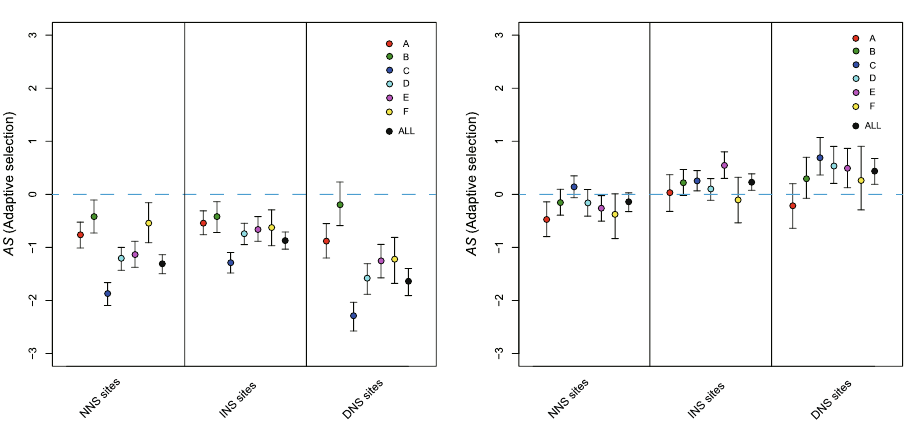
Figure 3. Adaptive evolution of non-synonymous variants in HBV. ( A – B ) Plots of AS statistics of NNS, INS and DNS variants. The calculation was performed using ( A ) low frequency and ( B ) high frequency variants separately. Low frequency variants were defined by < 1% DAF or singletons. AS was first computed based on polymorphic variants in each genotype separately and then all polymorphic variants were combined (dot in black). Genotypes G and H are not showed because of small sample size (Supplementary Tables S4 and S5). Error bars denotes the 90% confidence intervals derived from bootstrapping tests of 1000 times for AS . Blue dashed line denotes the neutral index, where AS = 0.